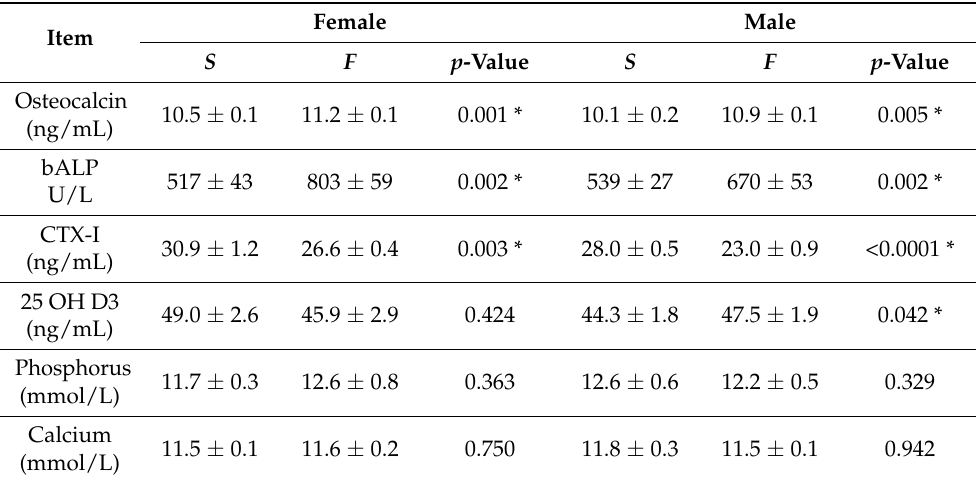
Table 5. Biochemical markers of bone metabolism and concentration of ionized calcium and phos- phorus in blood serum of female and male rats on the weaning